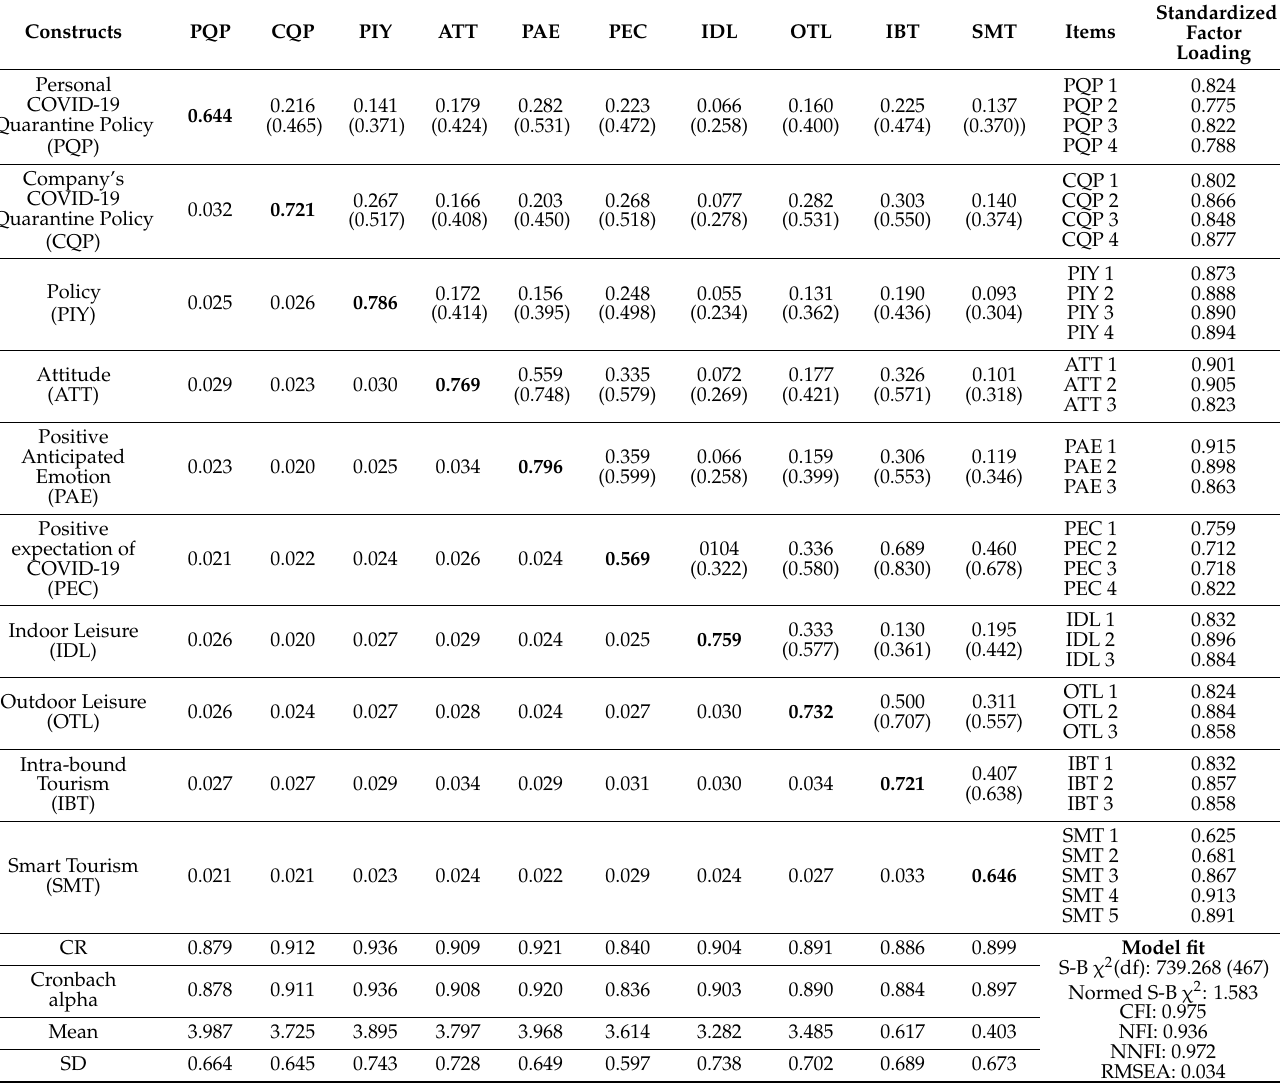
Table 2. The results of the measurement